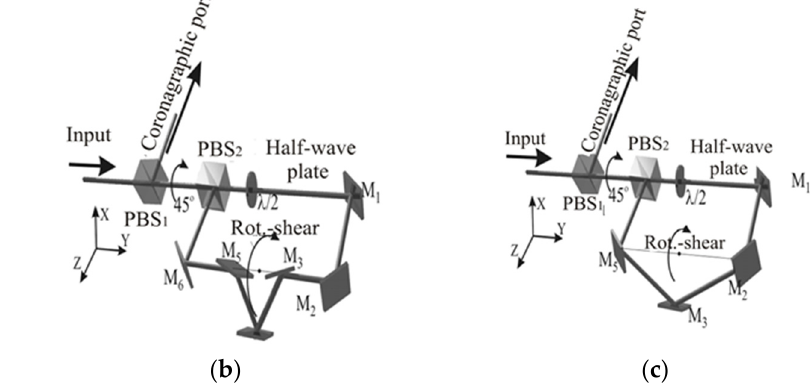
Figure 2. Optical schematics of common ‐ path nulling interferometers with various rotational ‐ shear angles acting as interfero ‐ coronagraphs (on their dark port): ( a ) CP ‐ AIC (RSI ‐ 180°) with rotational ‐ shear angle fixed at 180°; ( b ) RSI ‐ VAR with a variable rotational ‐ shear angle; ( c ) RSI ‐ 10° rotational ‐ shear angle fixed at 10°.